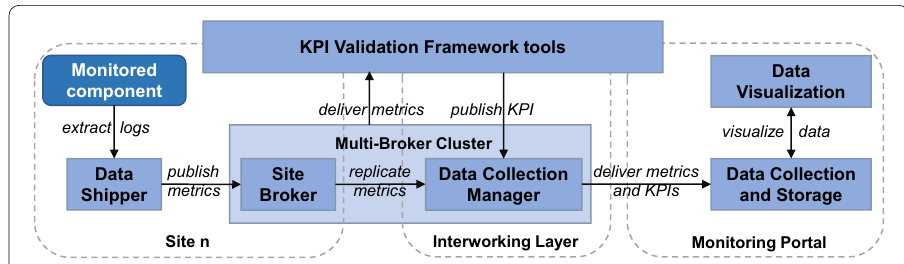
Fig. 2 Component chain that implements the general monitoring metrics